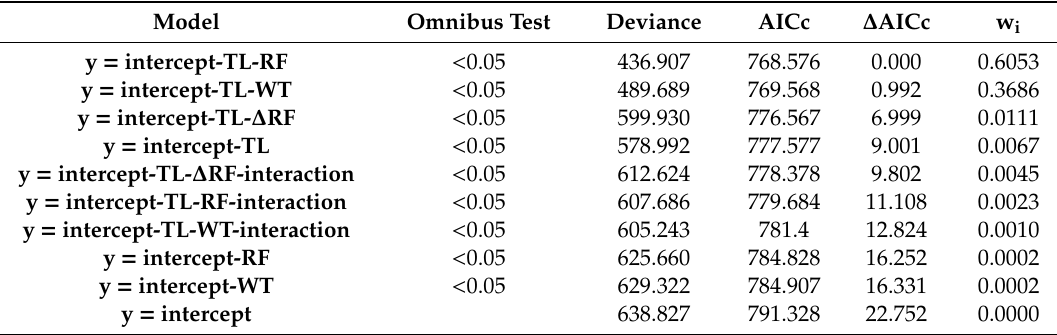
Table 2. Multinomial GLM models with Akaike weights (w i) > 0 ordered by increasing Akaike’s Information Criterion adjusted for small sample size (AICc), for the odds and extent of movements detected in the Guadiaro River eel population between October 2014 and June 2016. ∆ AICc: Di ff erence in ∆ AICc compared to the best model; w i : Akaike weights.TL = total length (cm), RF = river flow (level in meters), ∆ RF = increase in river flow (m) and WT = water temperature ( ◦ C).